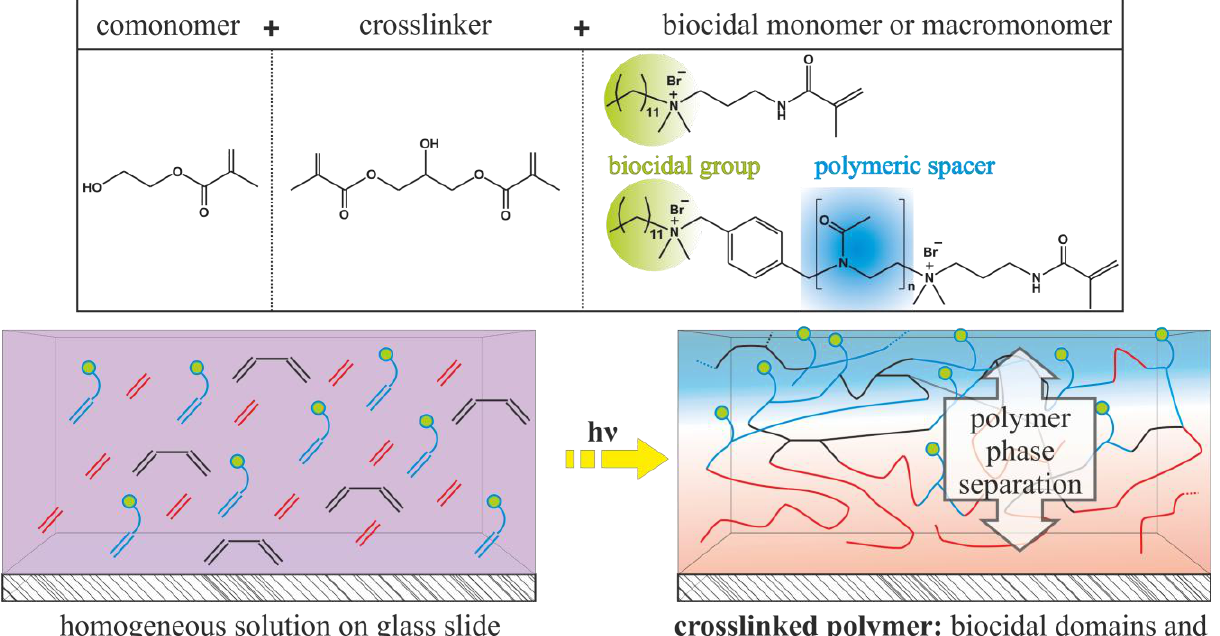
Figure 7. Surface-grafting of biocidal polymers via self-induced migration to the surface. Created according to